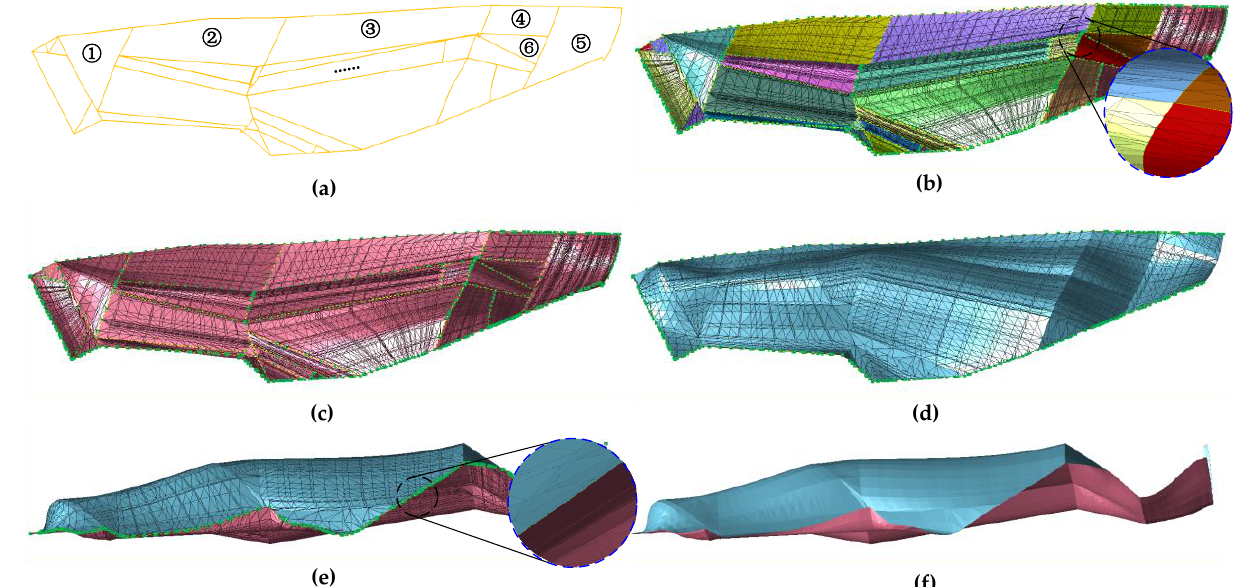
Figure 15. The splicing effect of a layered orebody model based on model clipping. ( a ) shows the mesh boundary polyline of each mesh in the lower layer of the layered orebody model. ( b ) shows the effect of orebody modeling and boundary clipping of each mesh. ( c ) shows the result of merging all meshes of the lower layer. ( d ) shows the upper mesh of the layered orebody model. ( e ) shows the splicing effect of upper and lower meshes. ( f ) shows the final layered orebody model. The labels ① to ⑥ show the individual sub-meshes for modeling.